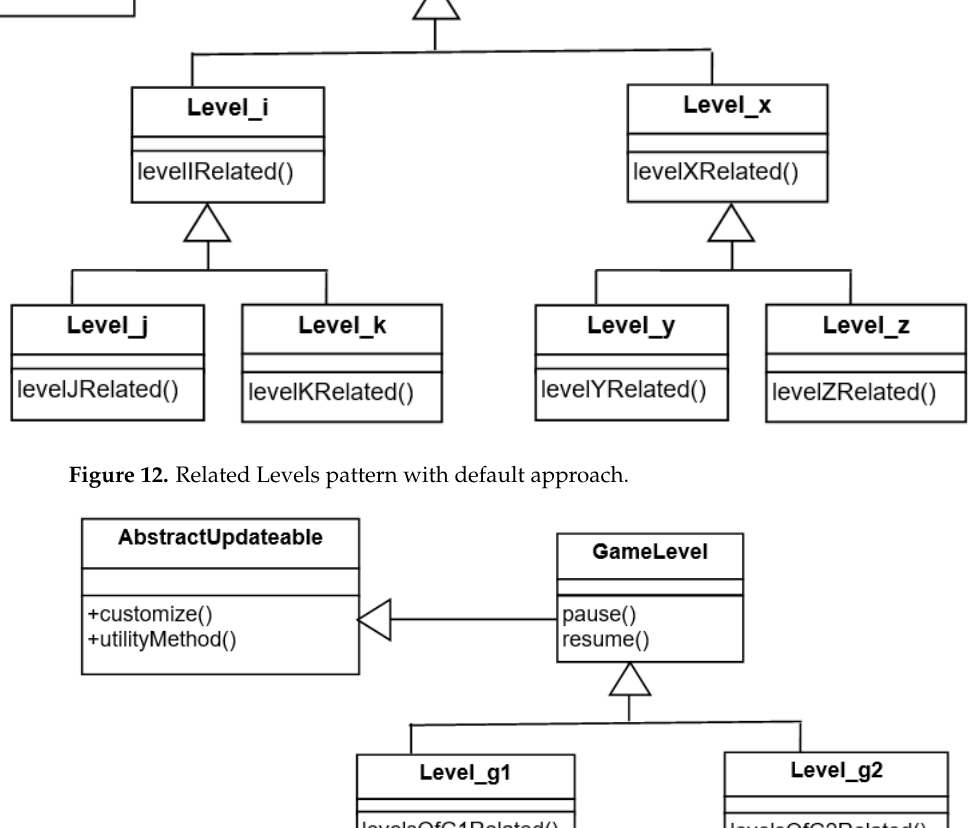
Figure 14. Second alternative approach for implementing Related Levels pattern. (5)